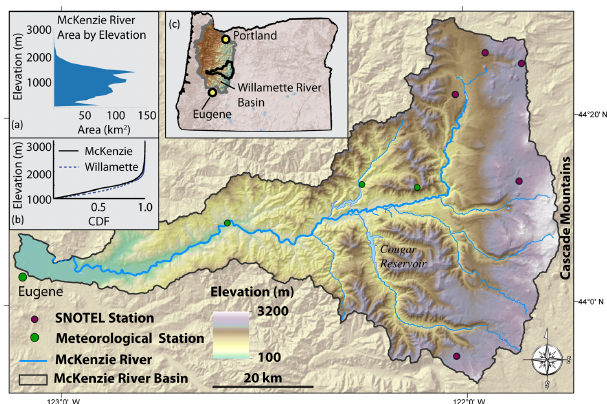
Figure 1. Context map of the McKenzie River basin and its geo- graphic relationship to the Willamette River basin. The geographic locations of the SNOTEL and other meteorological stations used as model forcings show the altitudinal range of inputs. Inset (a) repre- sents the area by elevation for the McKenzie River basin. Inset (b) presents the cumulative distribution functions (CDFs) for the ele- vation of the Willamette and McKenzie River basins for elevations above 1000m and is separated into 50m